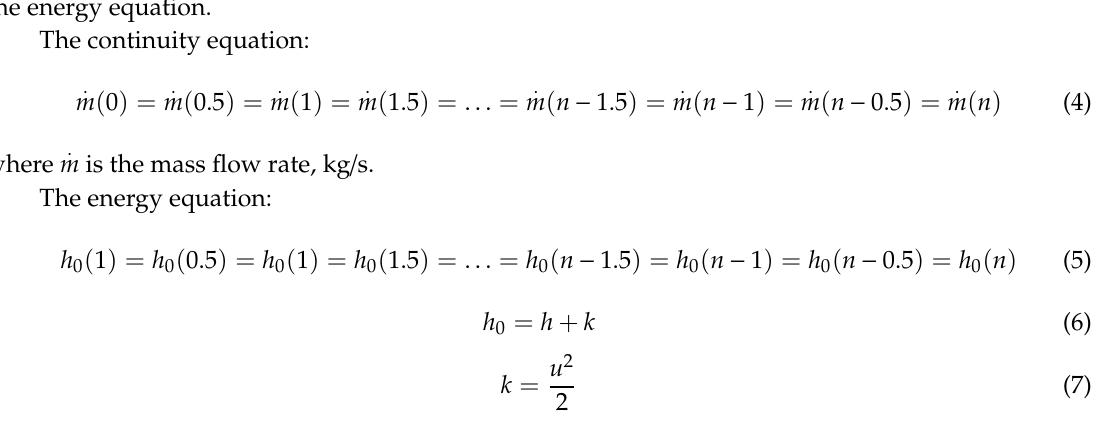
Figure 3. 1-D computation site distribution of labyrinth seal.